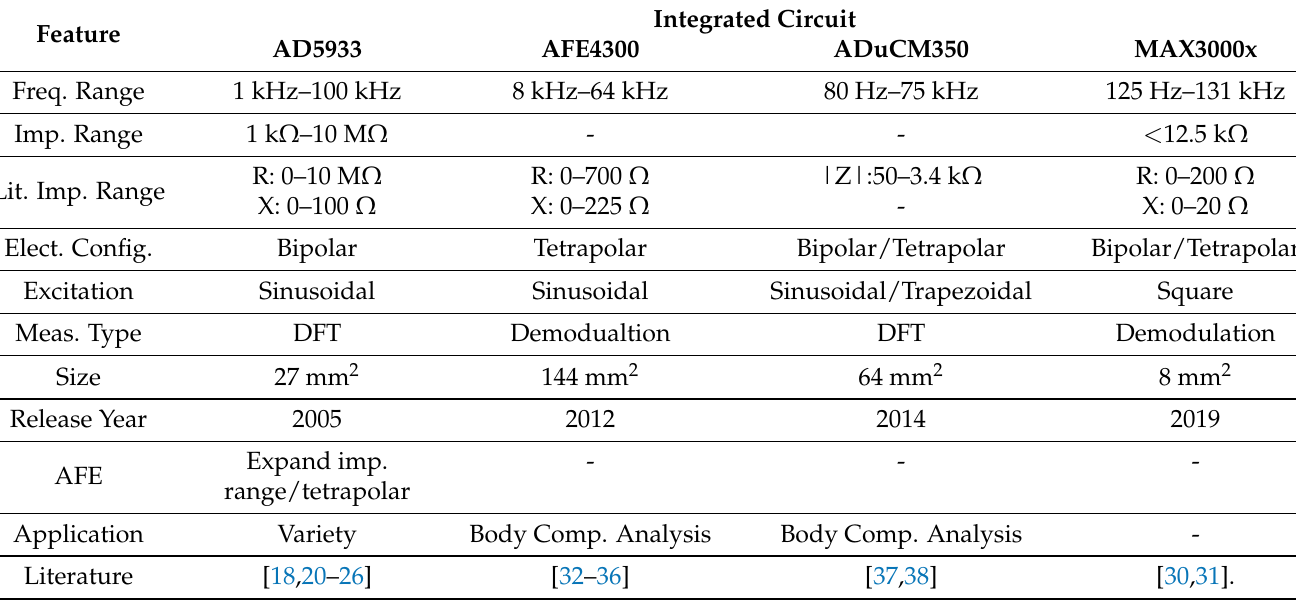
Table 1. Comparison of integrated circuits with bioimpedance